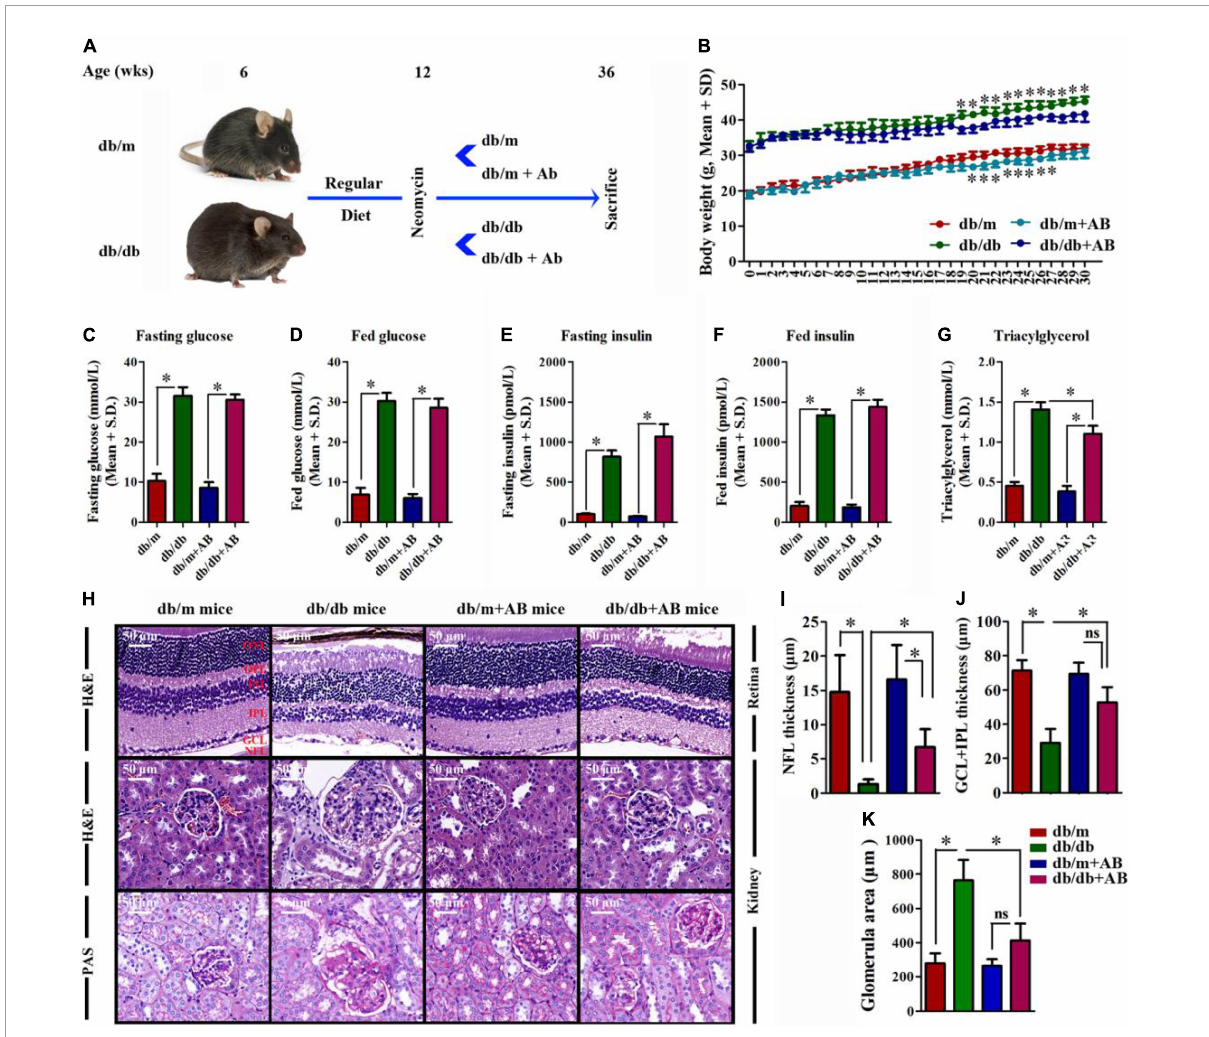
FIGURE1 The effect of obesity on metabolic variables exacerbated retinopathy and nephropathy. (A) Schematic representation of experimental timeline where half of the mice (Lepr db / db and Lepr db / m ) start a regular diet (RD) at 6 weeks and later half of these receive neomycin (AB) treatment from the age of 12 weeks until killing at week 36. (B) Weight gain of AB-treated mice compared to control mice; Error bars represent mean ± S.D. n = 8 in per group. ∗ P < 0.05. (C–G) The effect of obesity on metabolic variables including Blood glucose (C,D ), insulin (E,F) , and triacylglycerol (G) levels after 16 h of fasting (C,E) , and in the random fed state (D,F) in mice with or without AB-treatment. n = 8 in per group. ∗ P < 0.05. (H–K) HE staining was performed to detect vessels morphological changes of retinal sections ( H , Upper) followed by quantitation of the thickness of NFL (I) and GCL + IPL (J) . HE ( H , Middle) and Periodic Acid-Schiff (PAS) ( H , Bottom) staining was performed to detect glomerulus morphological changes of kidney sections followed by quantitation of the glomerular area (K) . Error bars represent mean + S.D. n = 8 in per group. ∗ P <